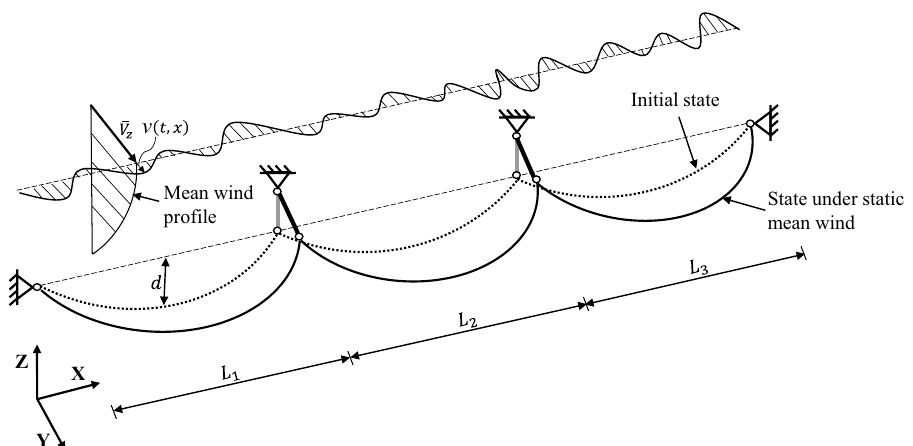
Figure 4. Multi-span transmission line section subject to turbulent